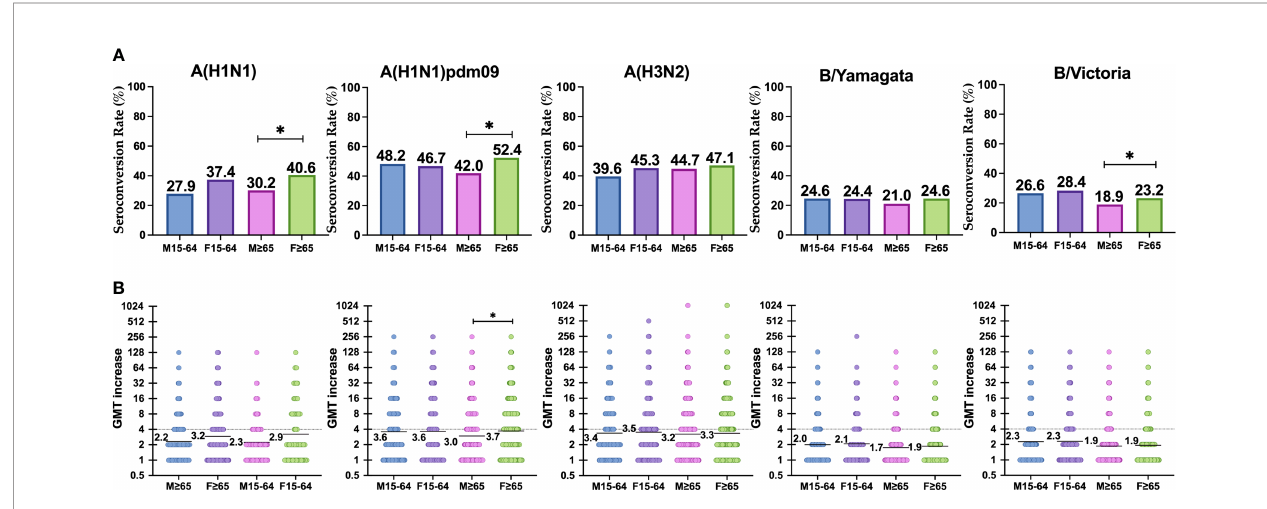
FIGURE 2 | (A) Represents the reponse to vaccination in terms of SCR (four-fold-induction of GMTs) in each group against each subtype. (B) Represents the increase of GMTs after vaccination in each group against each subtype. Signi fi cant differences (p < 0.05) are marked with